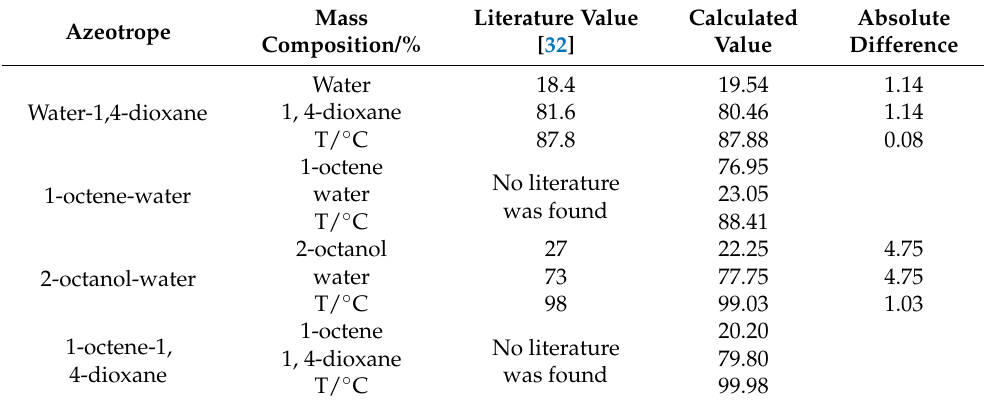
Table 2. Comparison of literature value and calculated compositions of the azeotropes involved in 1-octene hydration reaction at normal pressure.